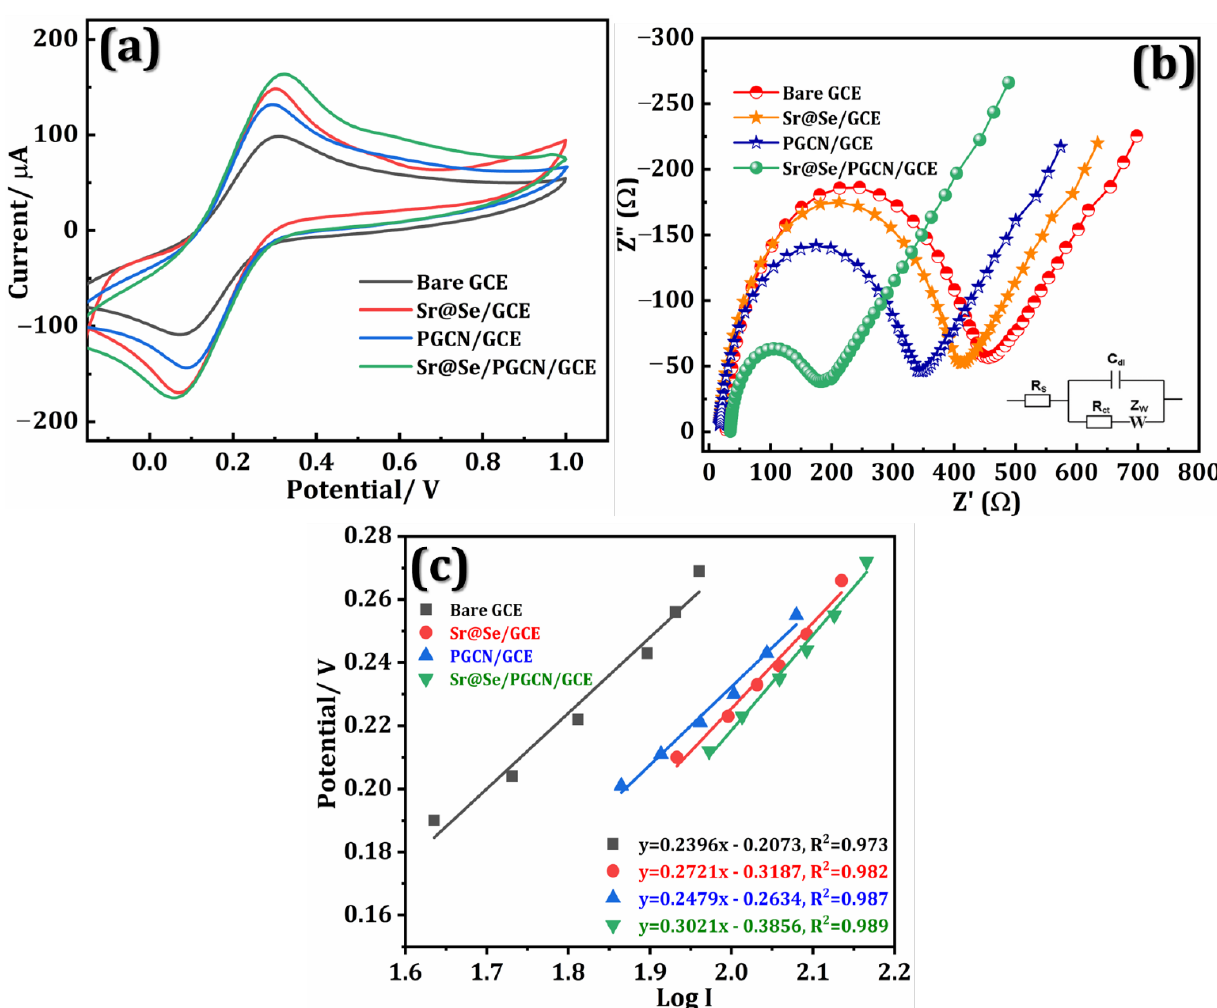
Figure 3. ( a ) CV curves and ( b ) EIS spectra and, ( c ) Tafel plot for bare GCE, Sr@Se/GCE,